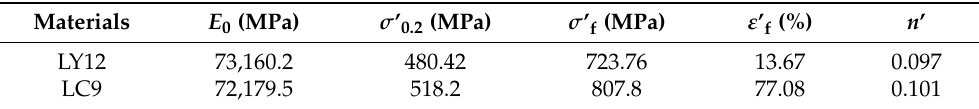
Table 3. Fatigue parameters of LY12 and LC9